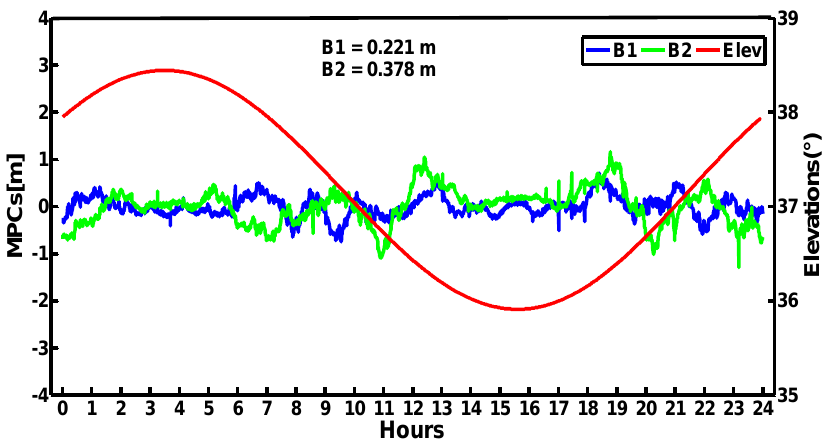
Figure 4. MPCs of the B1 and B2 codes, as well as the variation of the elevations of satellite C01 (GEO) at CHDU station on September 24, 2012.